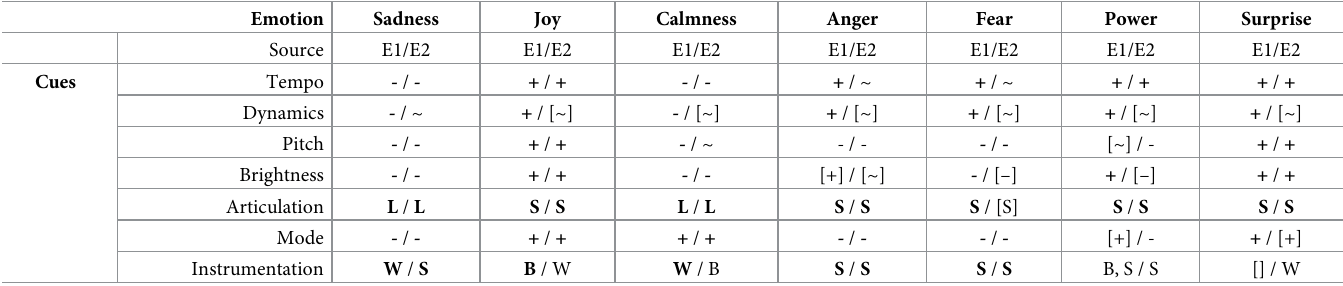
Table 4. A summary of cue levels used to shape the different emotions in Experiment 1 and